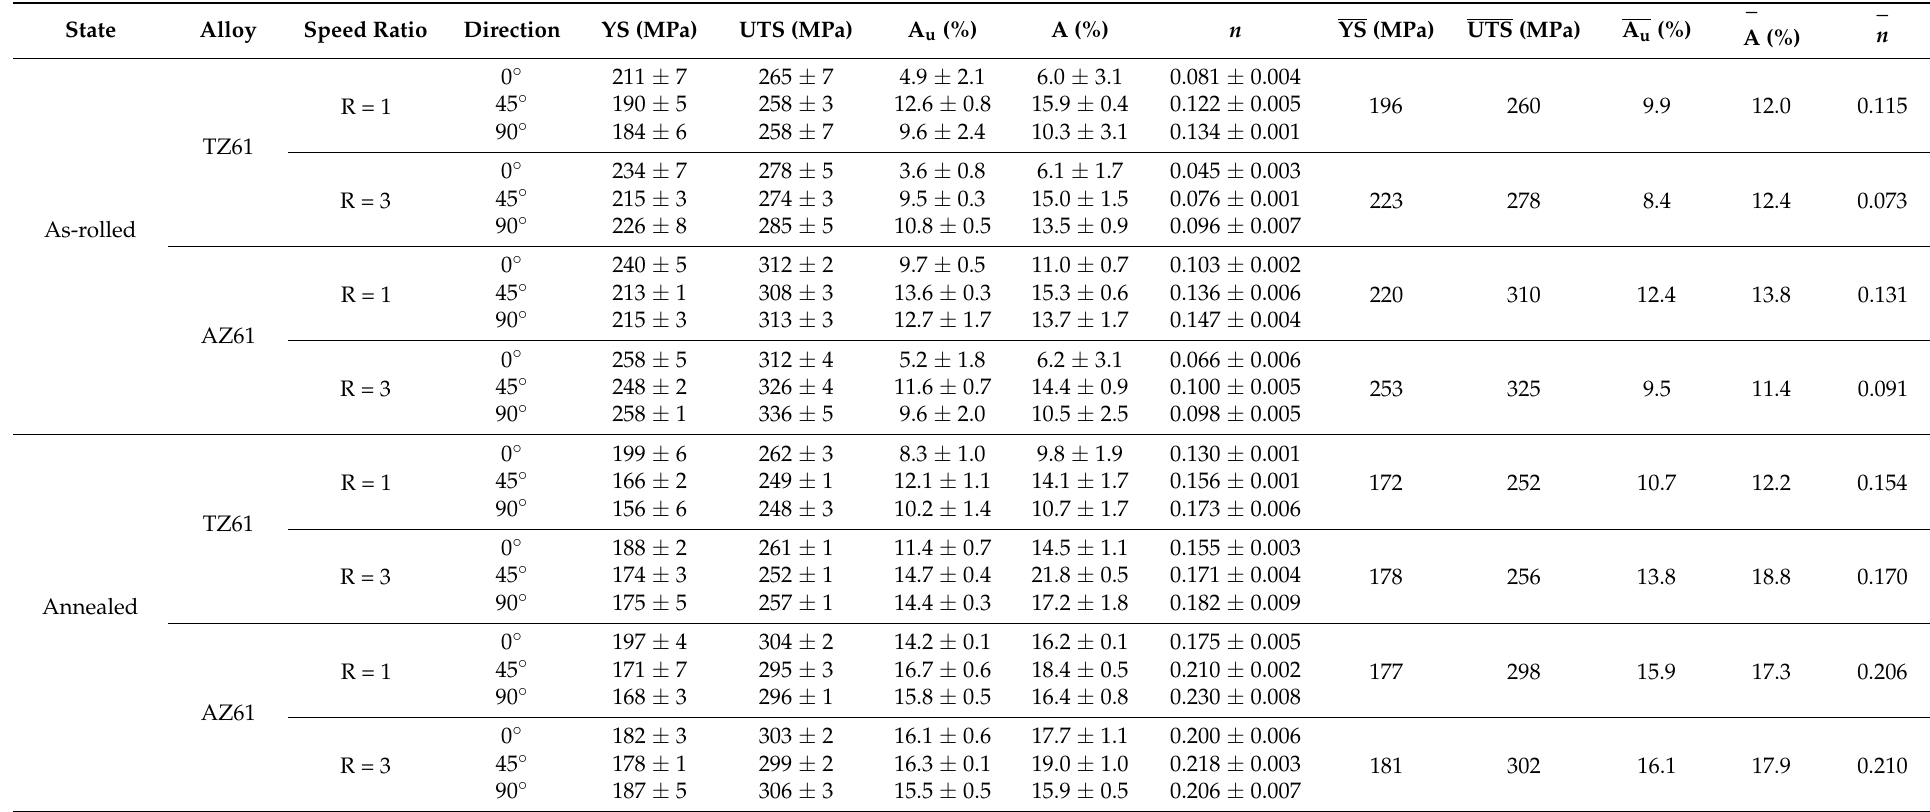
Table 1. Mechanical properties ( YS —yield strength, UTS —ultimate tensile strength, A u —uniform elongation, exponent) of the as-rolled and annealed TZ61 and AZ61 sheets processed with different speed